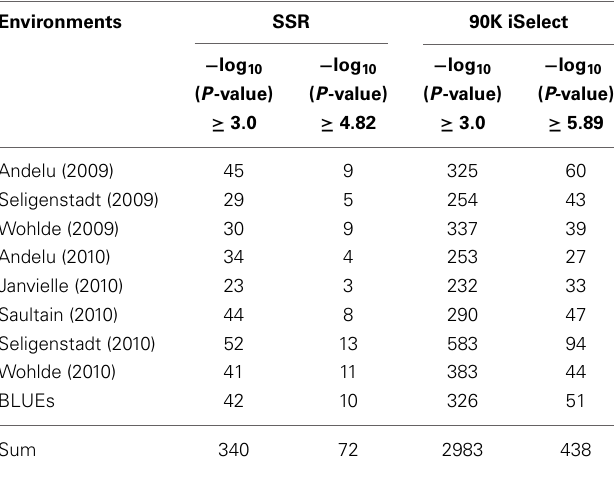
Table 1 | Number of MTAs per environment for the SSR marker and the SNPs on the 90K iSelect